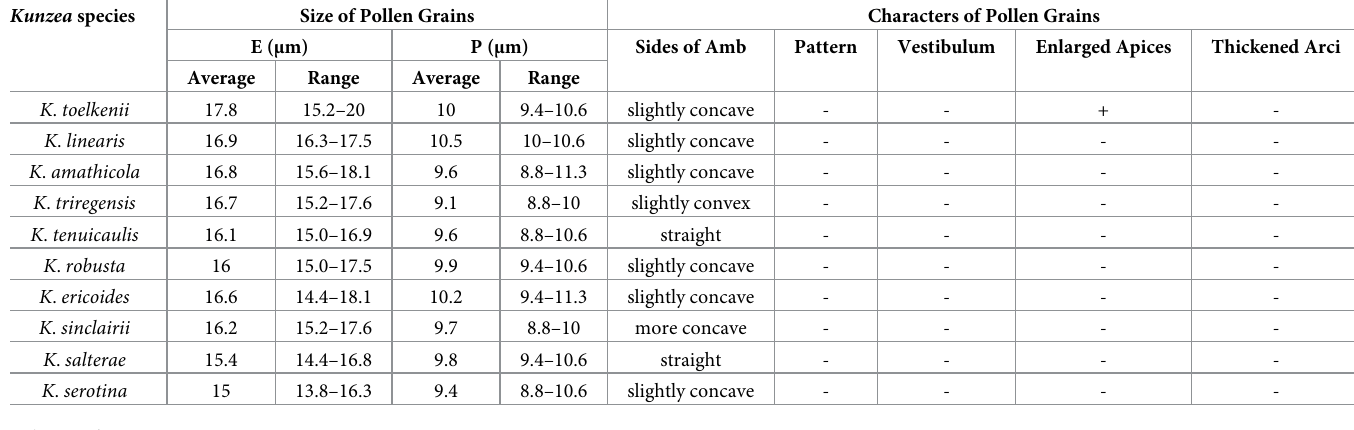
Table 2. Pollen morphological characters of Kunzea species (visual